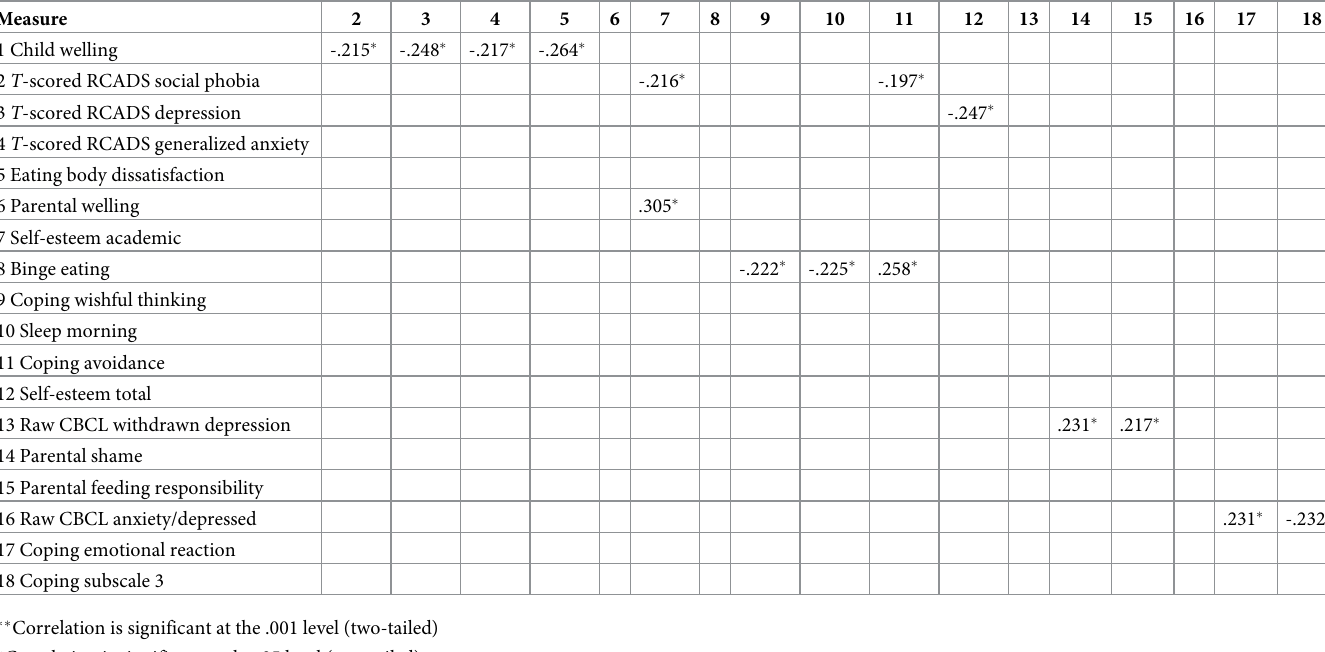
Table 5. Pearson’s correlations for mental health and wellbeing variables for diabetes